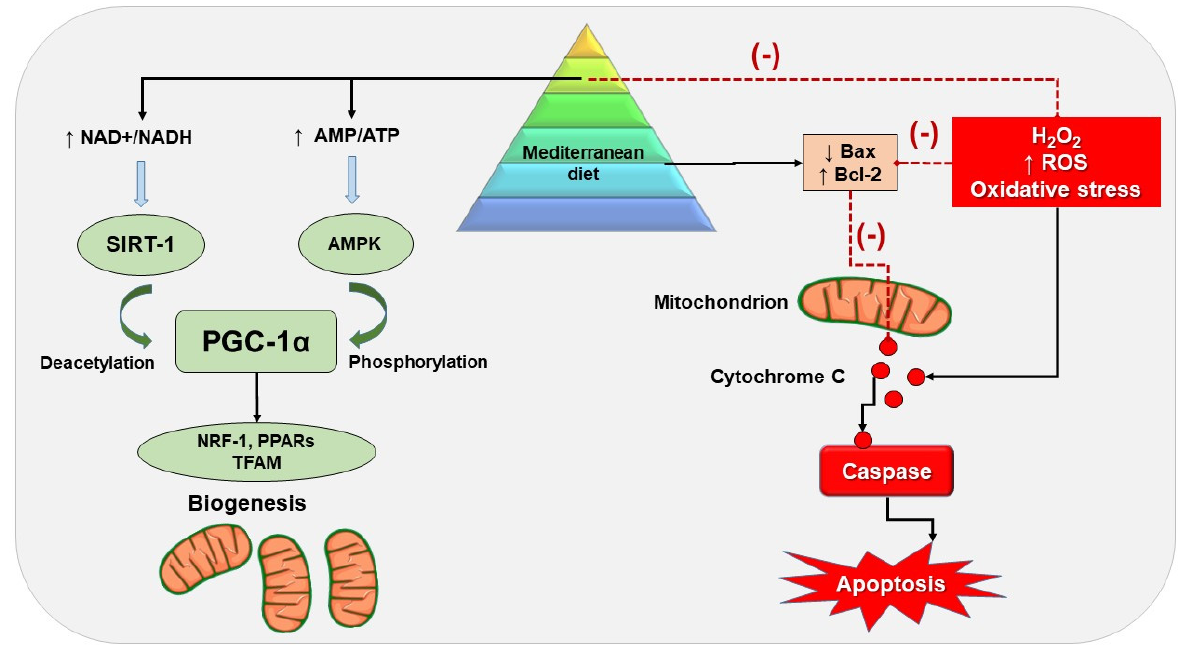
Figure 3. Potential molecular mechanisms of MD on mitochondrial dysfunction in MetS. The dotted red line represents inhibitory pathways. Abbreviations: AMPK: AMP-activated protein kinase; BAX: bcl2-like protein 4; Bcl − 2: B-cell lymphoma 2; NRF − 1: nuclear respiratory factor 1; PPARs: peroxisome proliferator–activated receptors; PGC − 1 α : peroxisome proliferator–activated receptor- gamma coactivator-1 α ; SIRT − 1: sirtuin 1; TFAM: transcription factor A, mitochondrial.